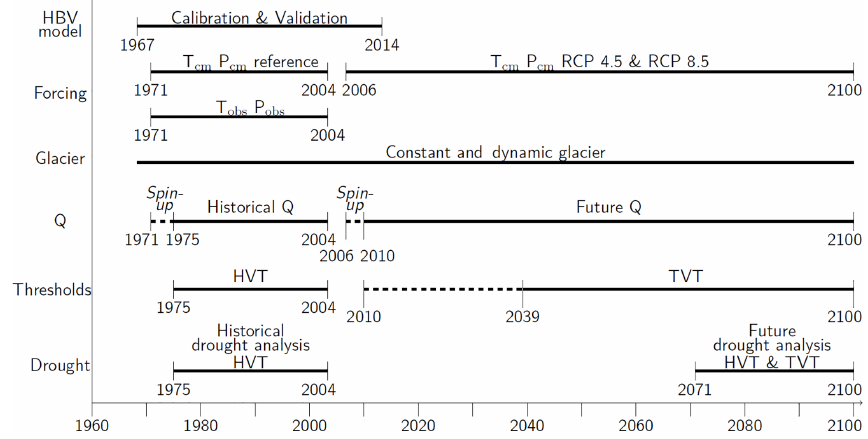
Figure 2. Timeline indicating the simulation periods, forcings and periods for threshold derivation and application. The different glacier area conceptualisations, constant and dynamic, are used in all simulation periods.